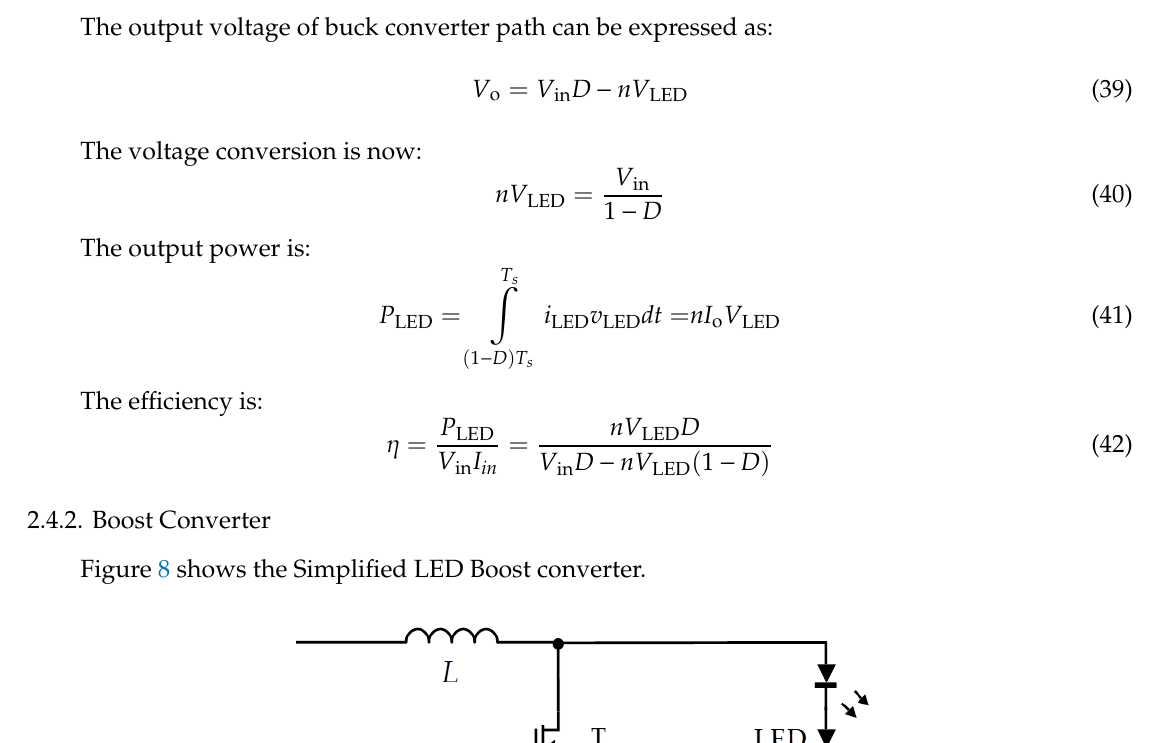
Figure 7. Simplified LED chopper like a “buck” converter.